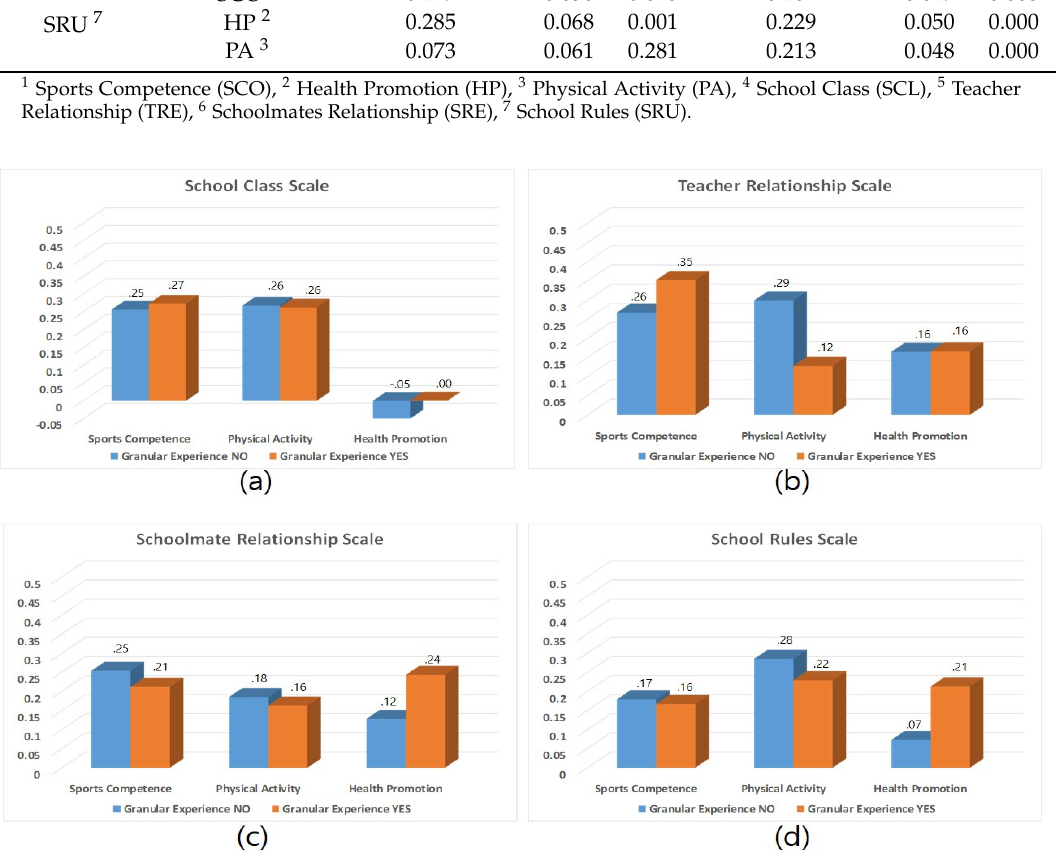
Figure 3. Effect of physical self-concept on school adjustment by award-winning career: ( a ) school class differences, ( b ) teacher relationship differences, ( c ) schoolmates relationship differences, ( d ) school rules differences.